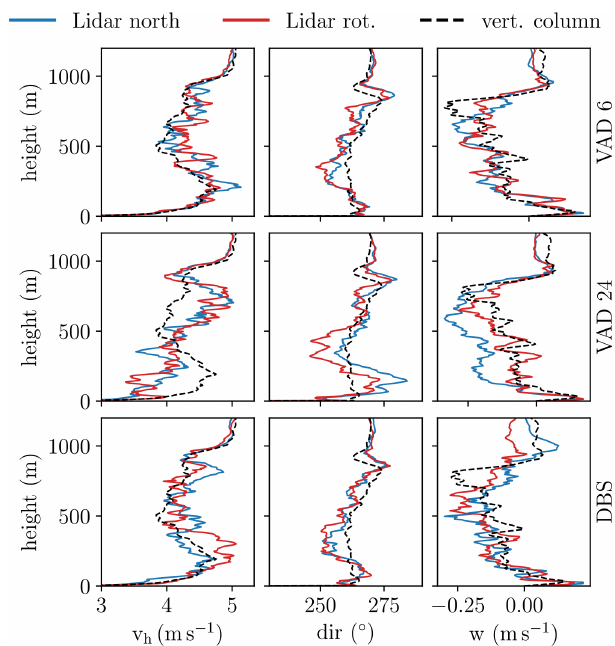
Figure 5. Simulation case 1: virtual lidar profiles obtained over one randomly selected 10min period with a zenith angle configuration of 15 ◦ using different scan schemes. Blue lines indicate profiles of north-oriented lidars and red lines indicate profiles of rotated lidars. For the VAD scans, lidars were rotated 30 ◦ to the east, while for the DBS scan, the lidar was rotated 45 ◦ to the east. Reference pro- files (LES values) along the vertical column directly above the lidar location (dashed black lines) are shown for